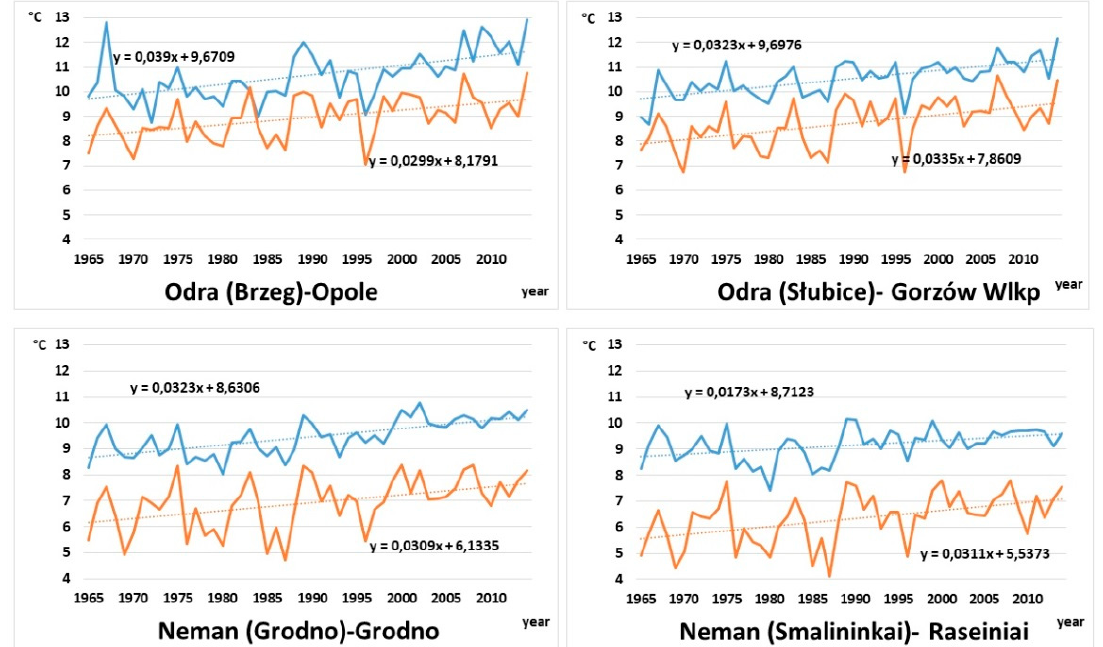
Figure 3. Changes in mean annual water (blue) and air (orange) temperature in the years 1965–2014; statistically significant linear trends at the level 0.05 and their equations (straight dotted lines).